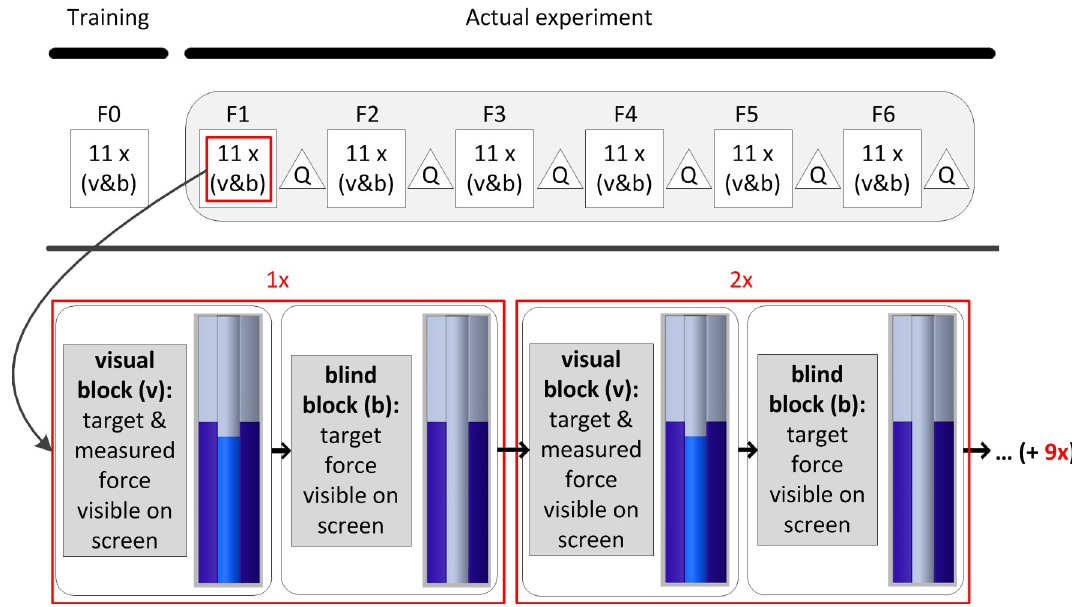
Fig 4. Experimental procedure of ‘no cable excursion’ trials. Flowchart illustrating the experimental procedure of the six ‘no cable excursion’ trials as shown in Fig 3. After practicing the force reproduction task at 22 N (F0), six force levels (10, 15, 20, 25, 30 and 40 N) were examined during 11 alternating visual and blind blocks. The force reproduction task at each force level (squares) was followed by a Nasa-TLX questionnaire (triangle). The order of force levels (F1 to F6) was counterbalanced over the subjects. The outer (purple) bars indicate the target force; the inner (blue) bar indicates the measured